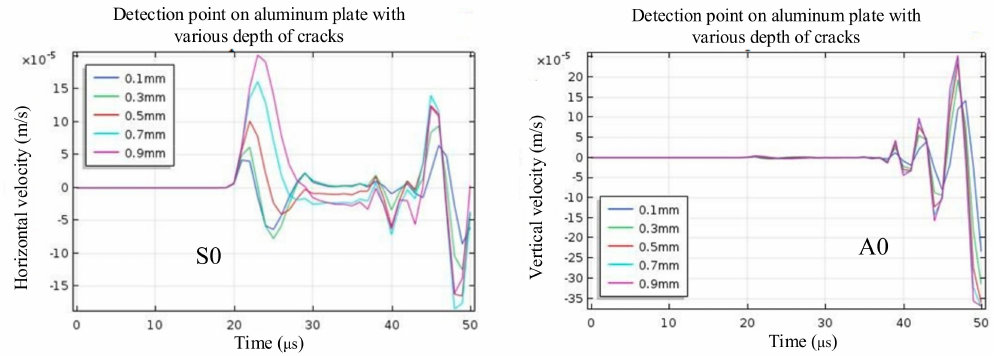
Figure 8. The velocity of the detection point on aluminium with various crack